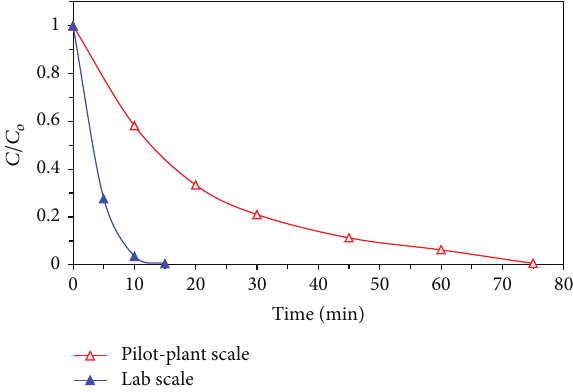
Figure 5: Photocatalytic degradation of PCBs (1.0ppm) in seawater using CM-n-TiO 2 at lab scale and pilot-plant